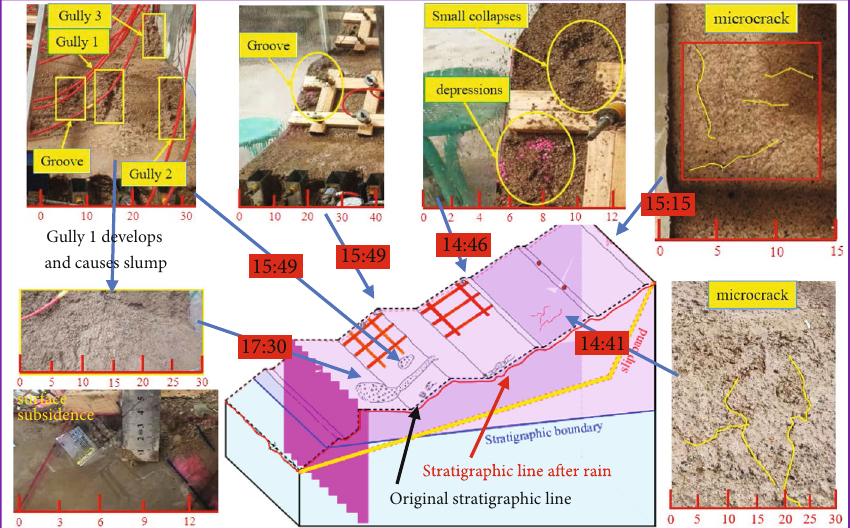
Figure 6: Coevolution process of slope and protective structure under the action of rainfall (the unit of dimension in fi gure is cm).